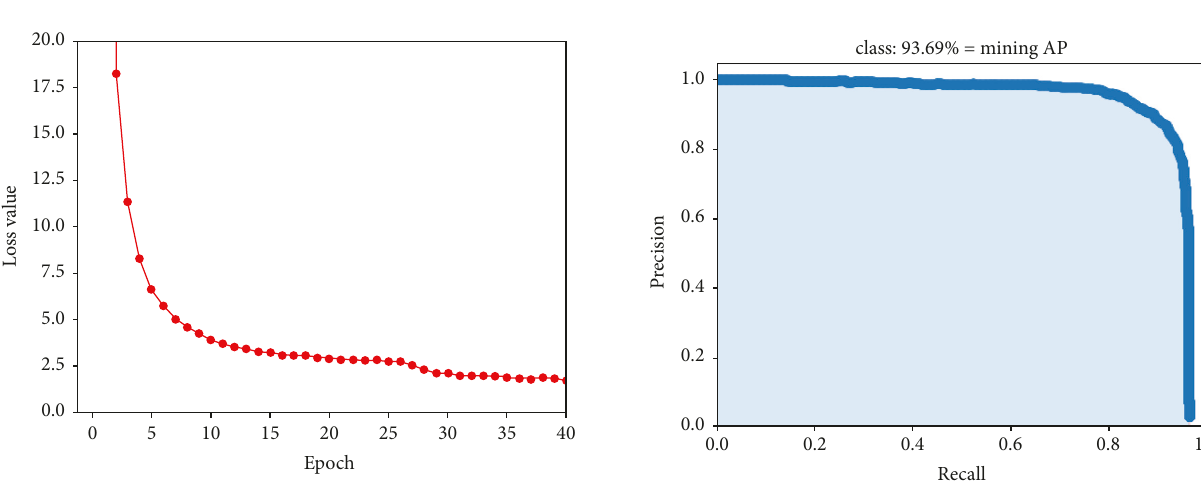
Figure 5: P - R curve of the CenterNet network. Note that the AP value is marked at the top of the